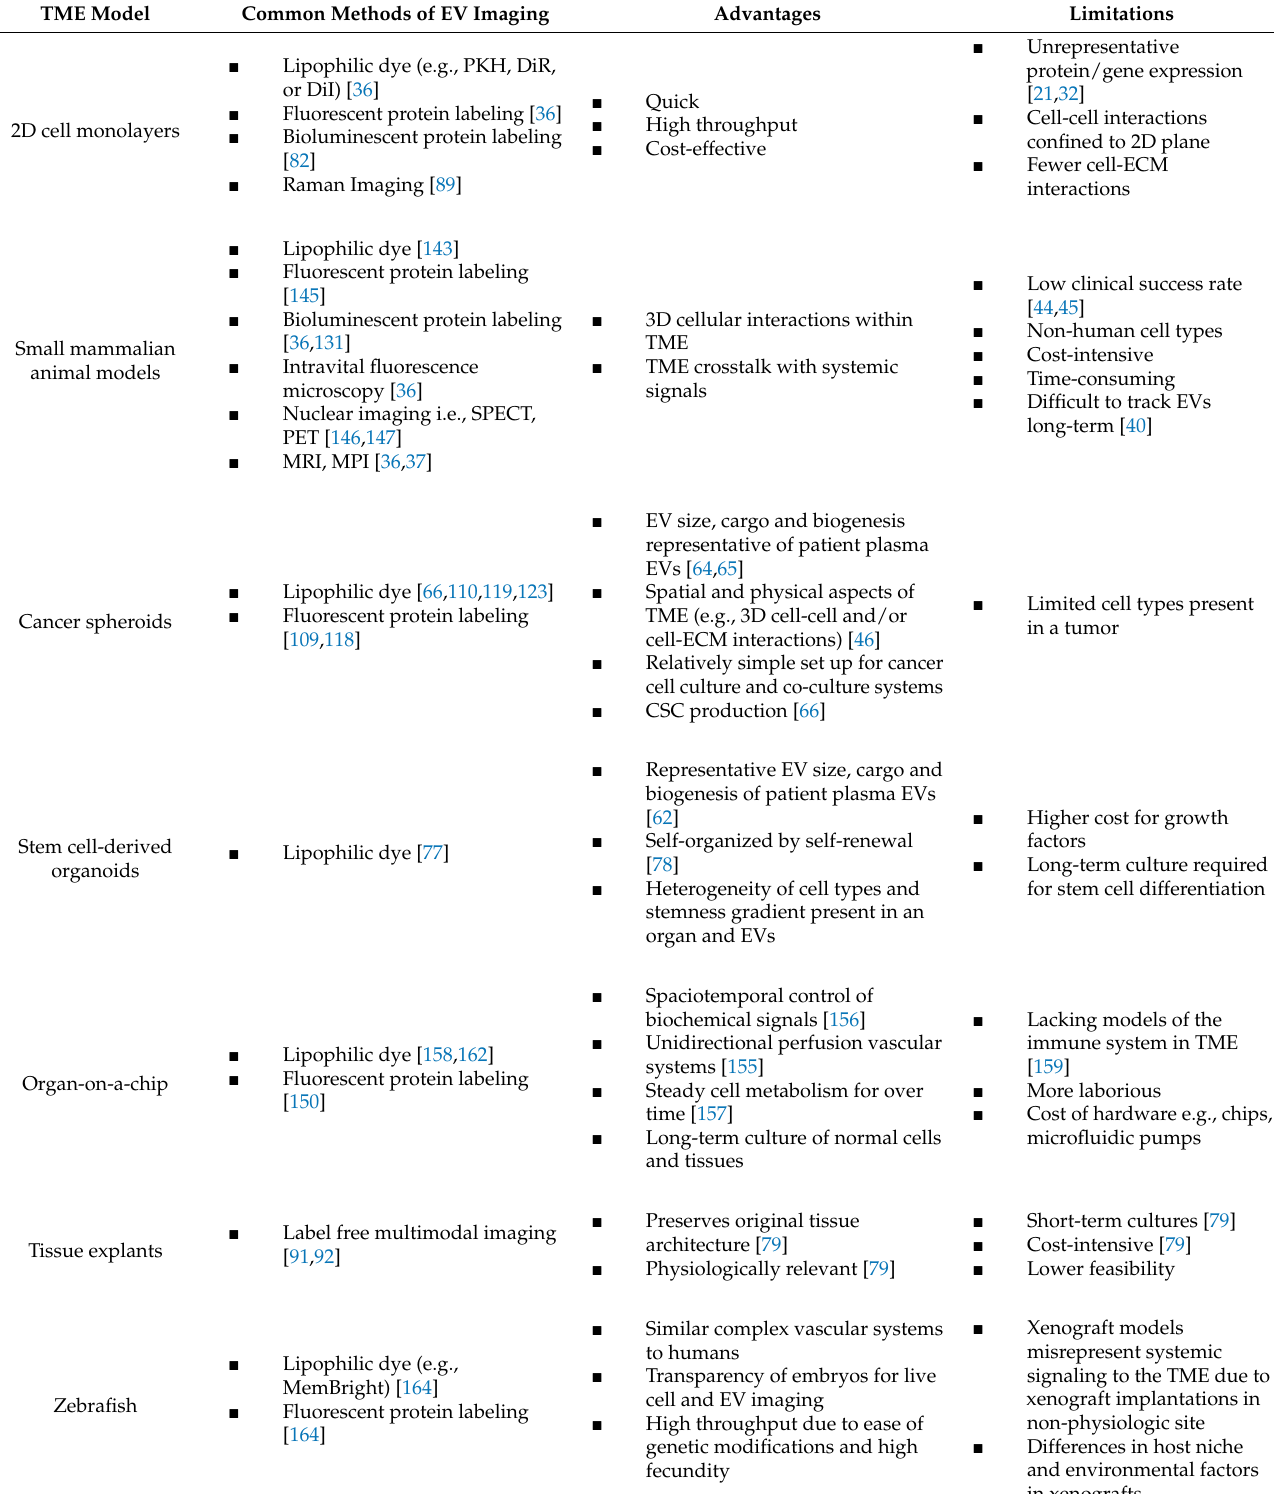
Table 1. Key advantages and limitations of the currently available 3D culture models for studying EVs. TME Model Common Methods of EV Imaging Advantages Limitations